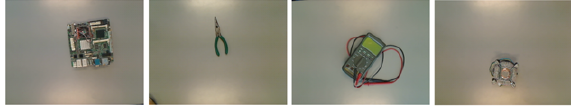
Figure 10: Examples of objects learned in our laboratory.